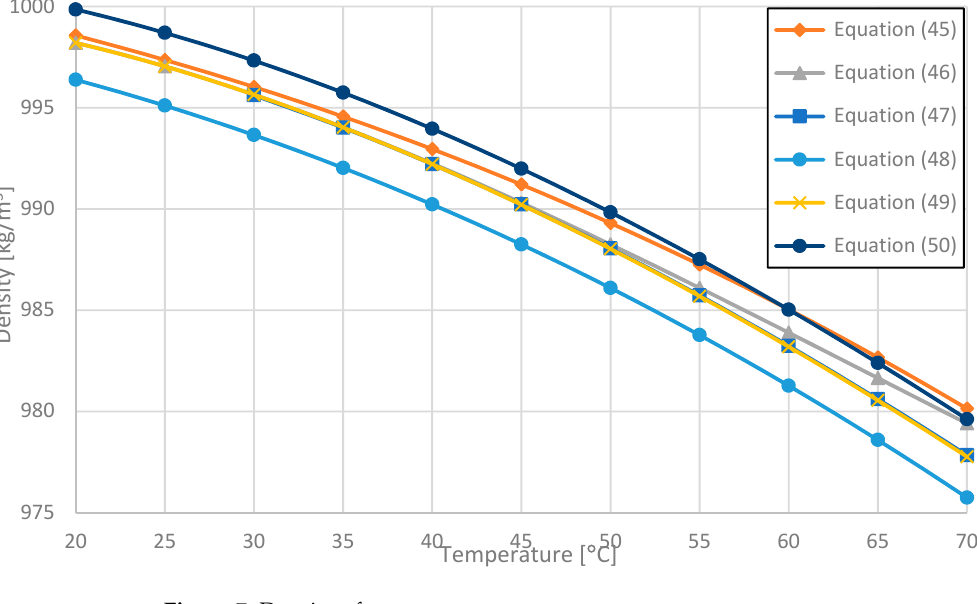
Figure 7. Density of water.